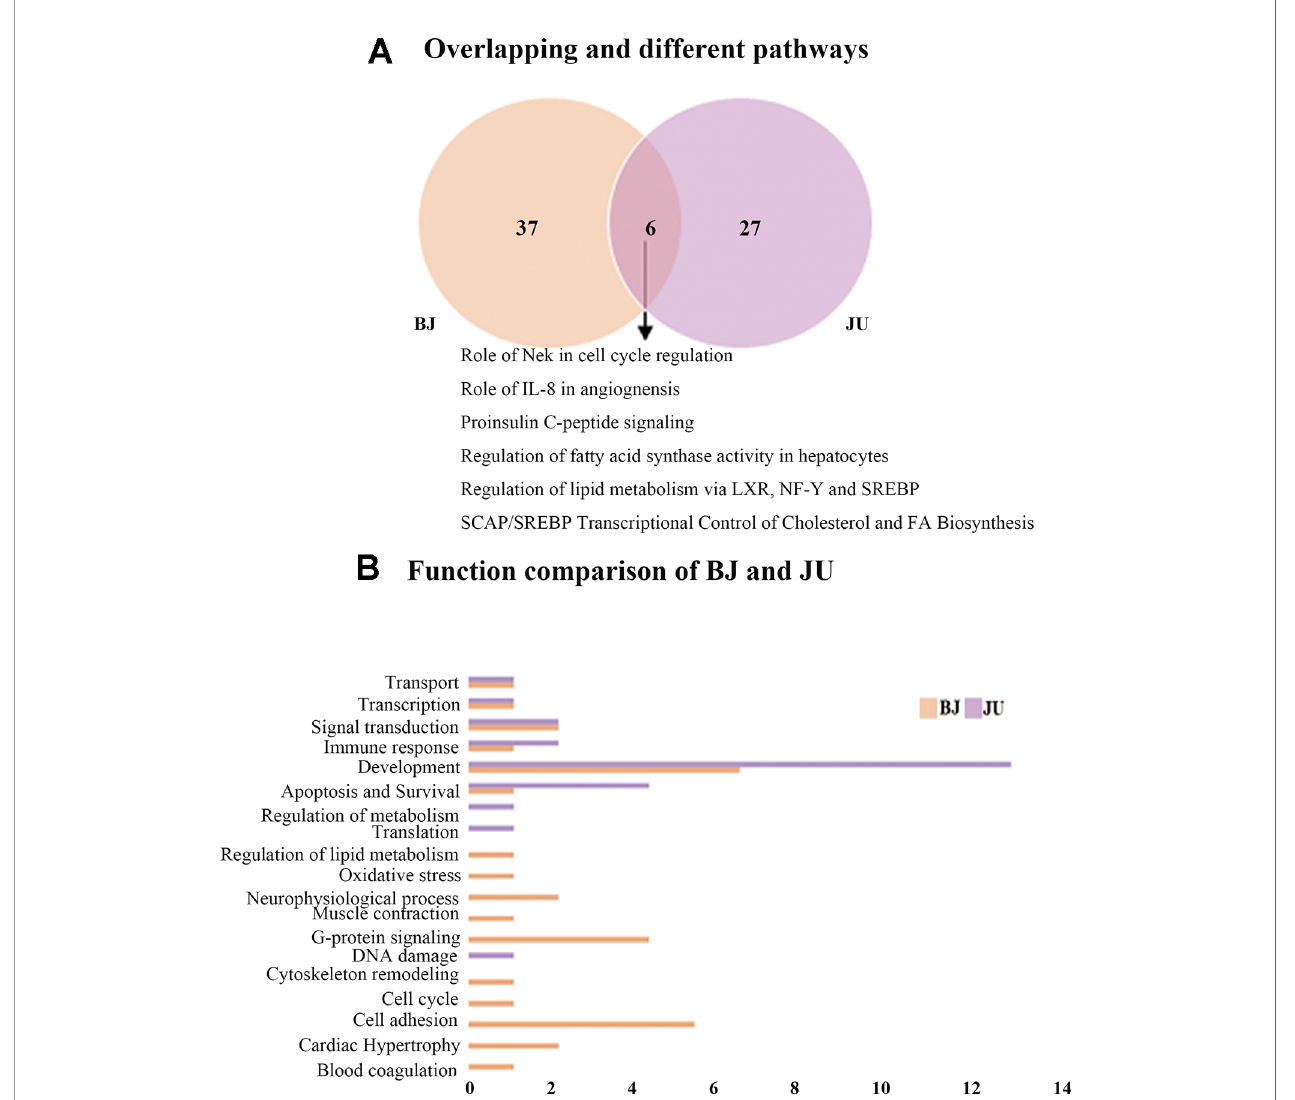
FIGURE 3 | The Wayne fi gures of overlapping and different biological functions and pathways among groups. (A) The Wayne fi gures of overlapping and different pathways between BJ and JU. (B) The functional comparison between BJ and JU. Only signi fi cant functions are shown in this fi gure based on a P value <0.05 and a fold change >1.5 between